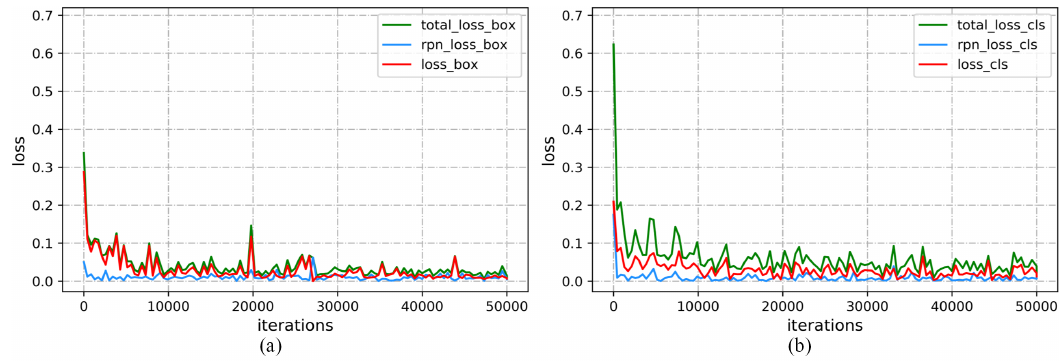
Figure 8. Training loss curves: ( a ) the regression loss and ( b ) the classified loss.